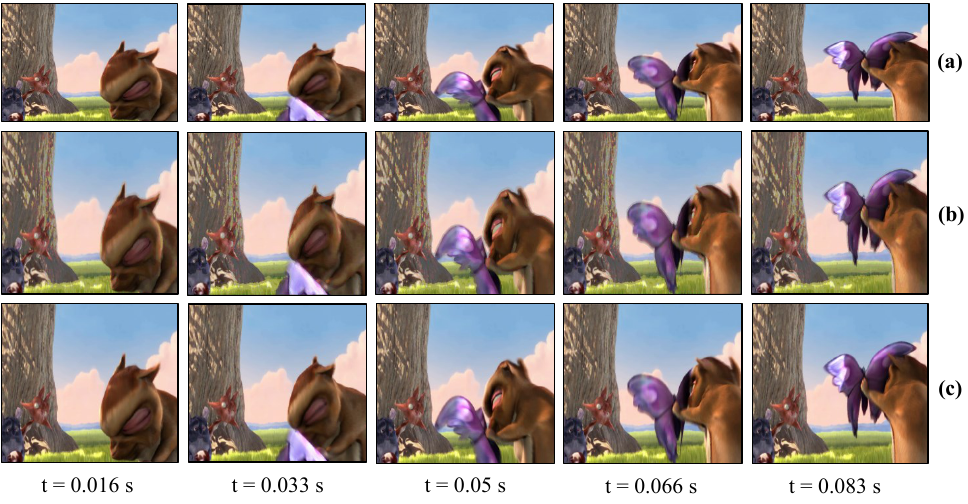
Figure 18. Reconstructed saved image sequence on a plain background: ( a ) 1920 × 1080 input image, ( b ) 510 × 459 gray-code image without background subtraction, and ( c ) 510 × 459 gray-code image with background